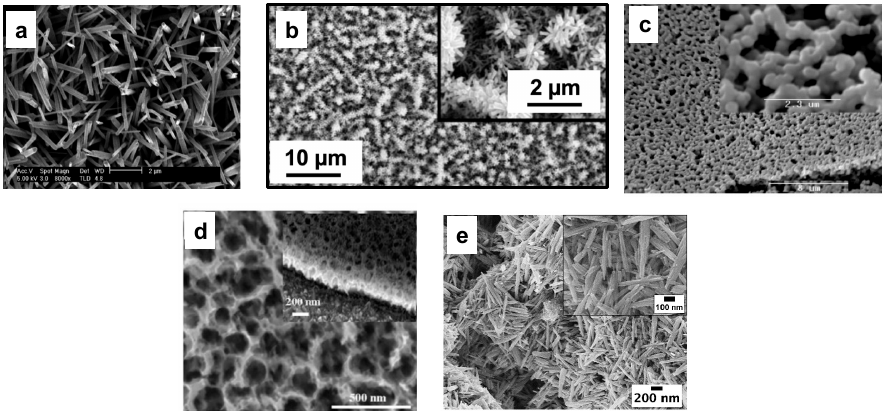
Figure 4. SEM images of WO 3 nanostructures (nanowires, nanorods, mesoporous and nanostructured film, nanospheres, and nanorods, respectively) synthesized ( a ) by thermal evaporation [36]; ( b ) by hot wire CVD [37]; ( c ) by sol-gel method [38]; ( d ) by electrochemical anodization [39]; and ( e ) by hydrothermal synthesis [29]. Reproduced with permission.